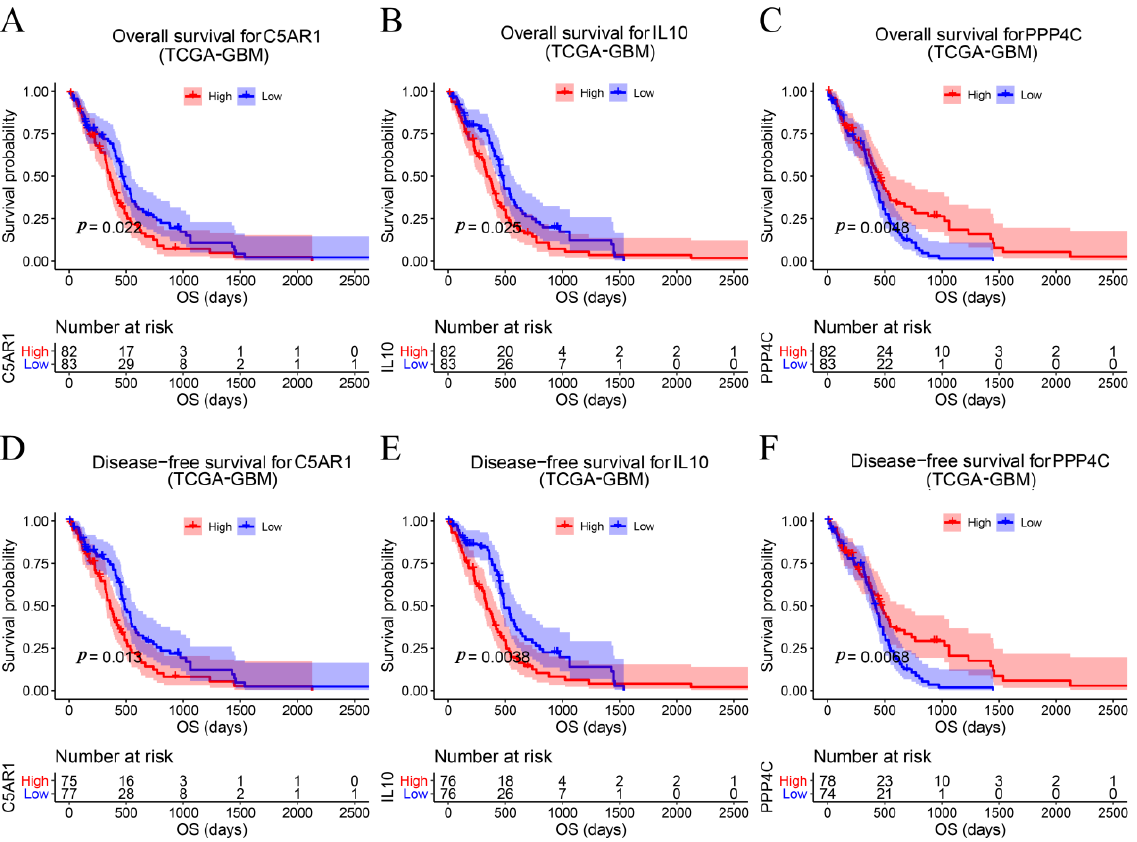
Figure 4. Verification of hub genes. Kaplan–Meier survival curve shows that GBM patients with higher hub gene expression had considerably lower overall survival—( A ) C5AR1, ( B ) IL10, and ( C ) PPP4C—and disease-free survival—( D ) C5AR1, ( E ) IL10, and ( F ) PPP4C.